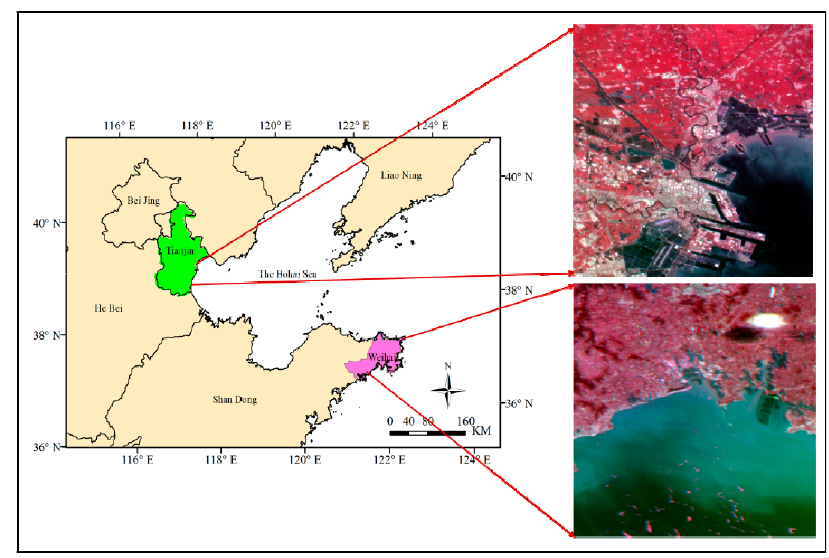
Figure 2. The two study areas used in this work.